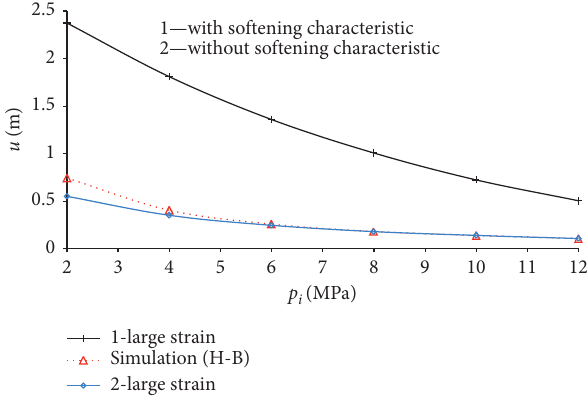
Figure 6: Relationships between displacement activity wall and operating